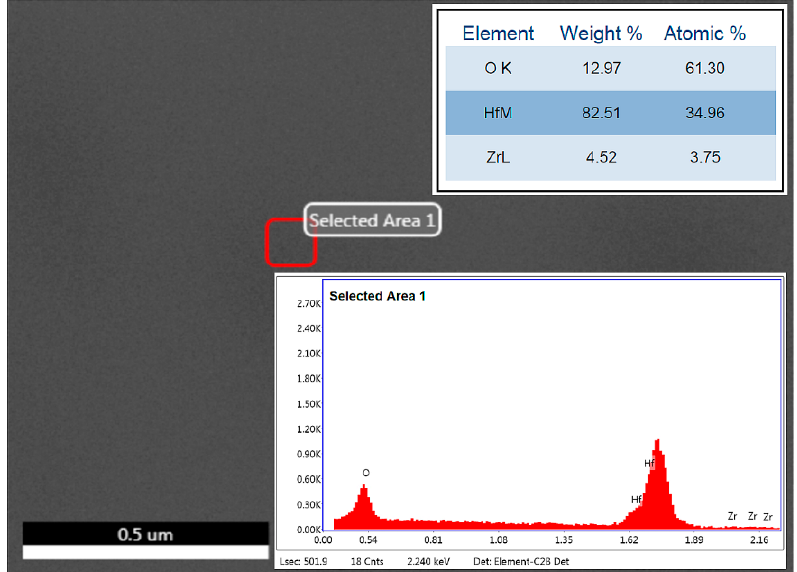
Figure 1. Energy-dispersive X-ray (EDX) analysis spectra of the 6-nm-thick HfZrO film. Grazing incidence X-ray diffraction (GIXRD) and piezo-response force microscopy (PFM) measurements were used in order to validate the ferroelectricity of the HfZrO thin film. GIXRD measurements were performed while using a high-resolution X-ray diffractometer that employs Cu